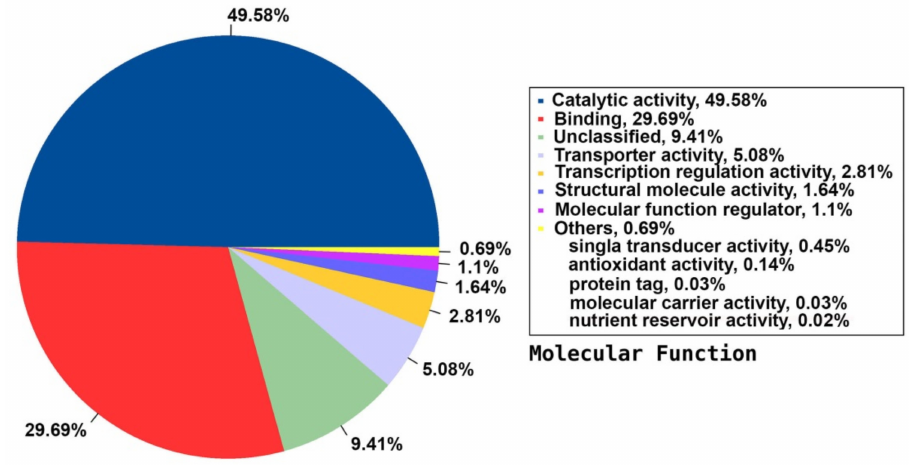
Figure 5. Distribution of the annotated MF to the GO database using the detected unigenes of the jojoba transcriptome of developing